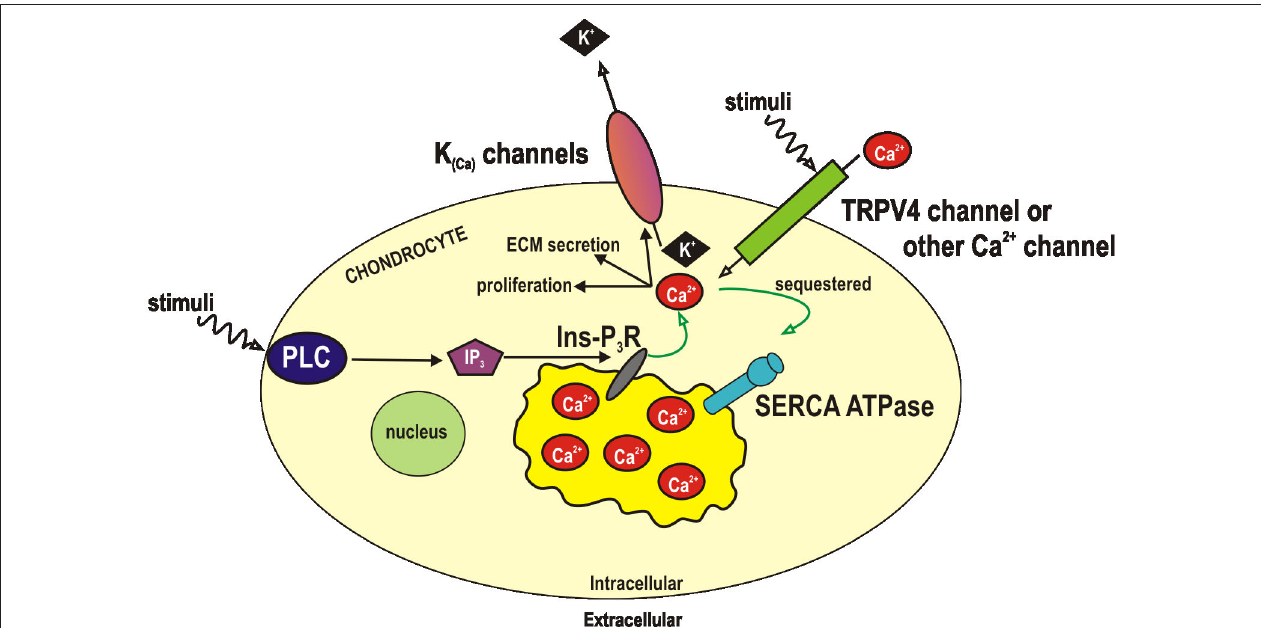
cation permeant ion channels. Both of these pathways could in turn, be activated by either mechanical or other (e.g., inflammatory) signals. ECM, extracellular matrix; Ins-P3-R, inositol trisphosphate receptor; IP3, inositol trisphosphate; K calcium activated potassium channels; PLC, phospholipase C; SERCA, sarco/ endoplasmic reticulum Ca 2 + -ATPase; TRP, transient receptor potential